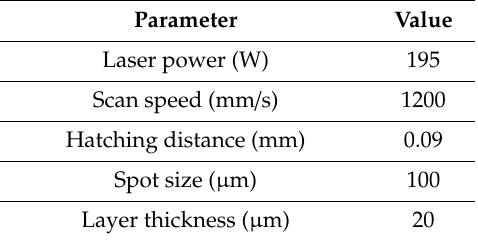
Table 3. Optimized selective laser melting (SLM)